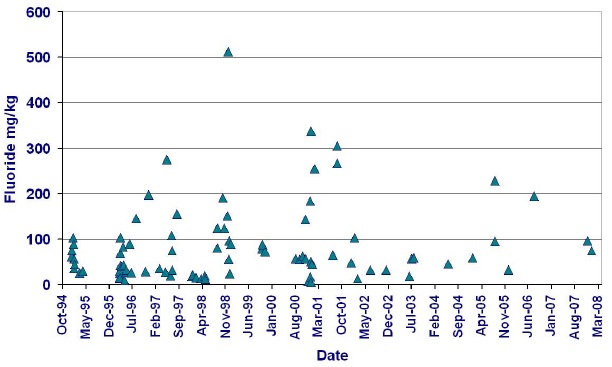
Fig. 3. Fluoride concentrations in leachates (mgkg − 1 ) of various eruption